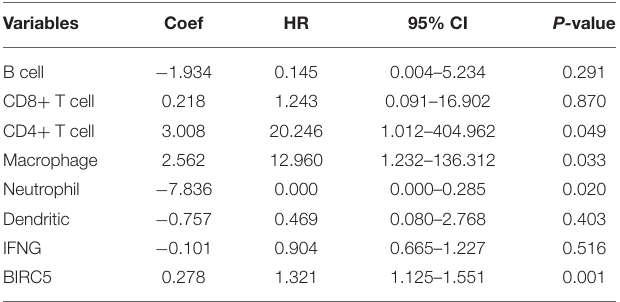
TABLE 4 | Multivariate Cox regression analyses of immune cells and hub genes with OS.